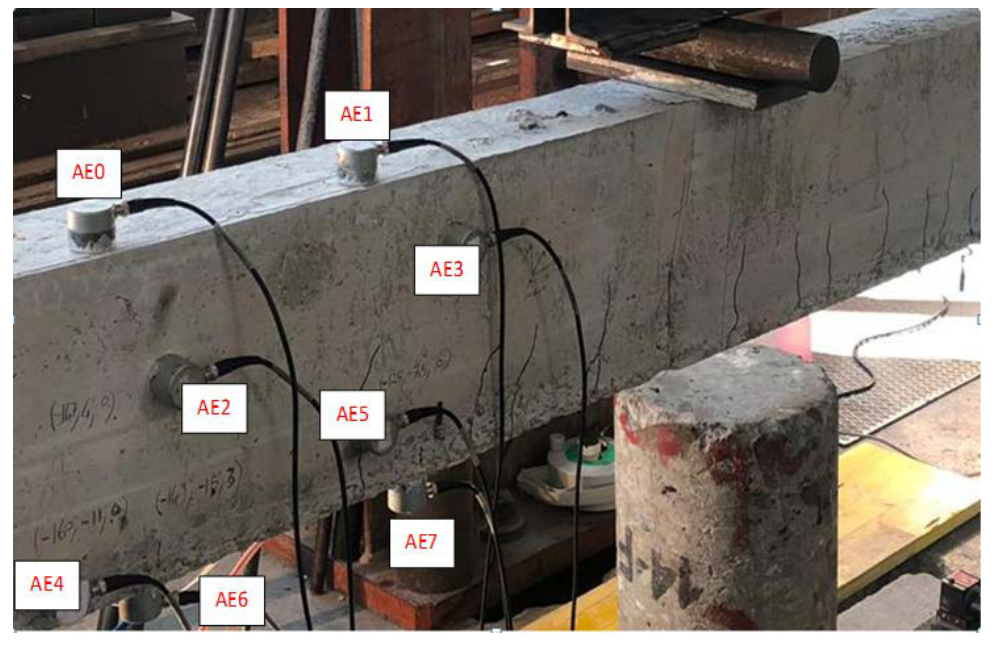
Figure 14. Crack pattern at loading step #7 and numbered AE sensors.